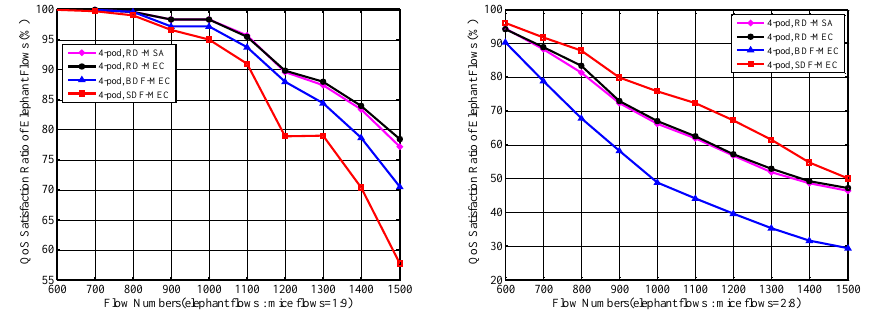
Figure 10. QoS satisfaction ratio of elephant flows in 4-pod Fat-Tree.